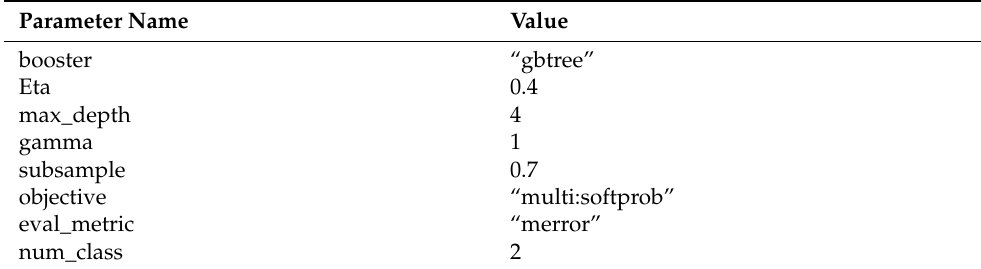
Table 4. Parameter values for the XGBoost